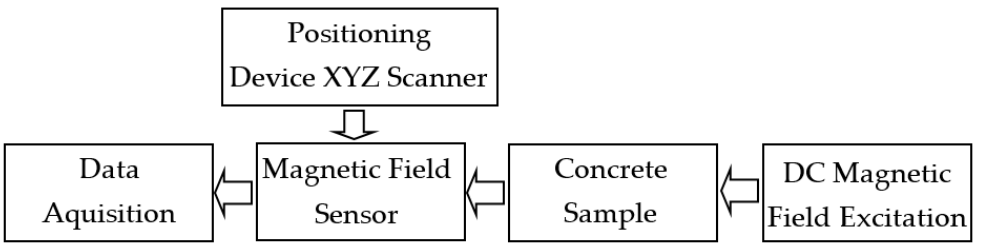
Figure 4. Block scheme of the measuring system.